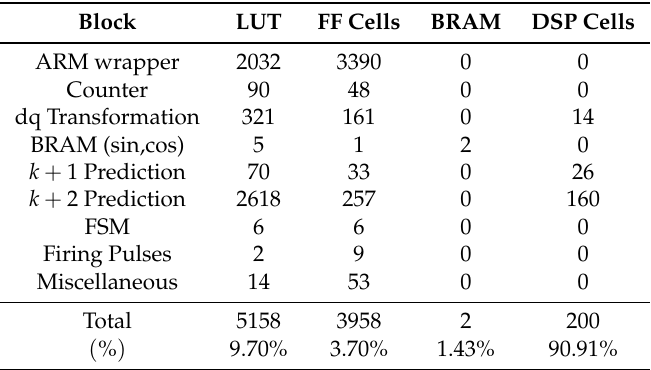
Table 3. Hierarchical utilization for parallel method.